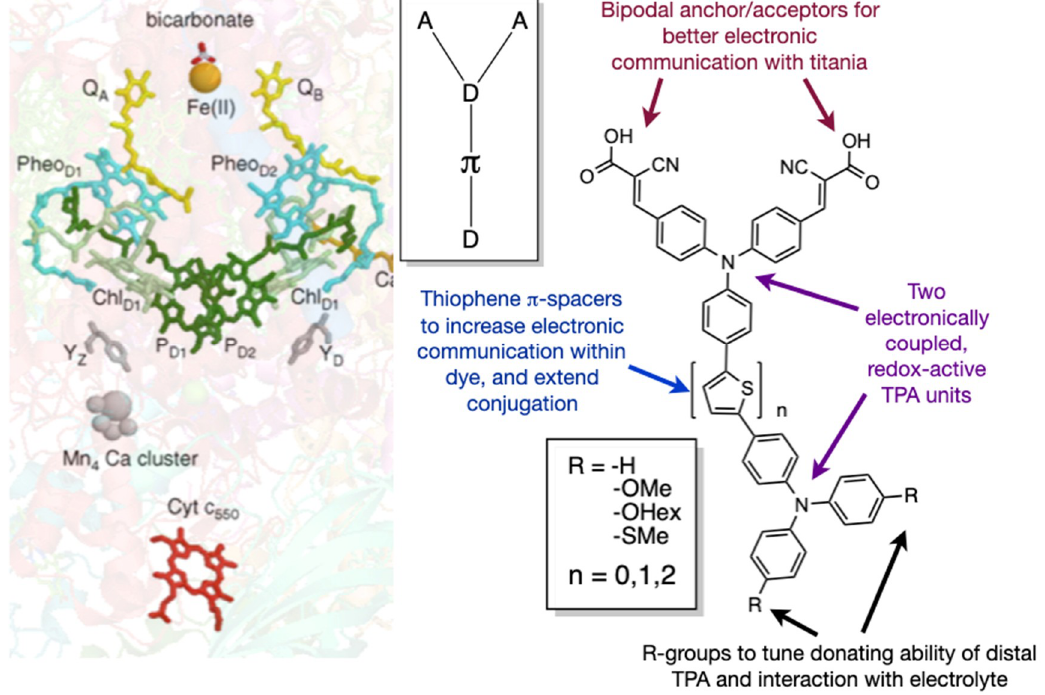
Figure 1. A family of bichromic-bipodal dyes inspired by the molecular machinery found in Photosystem II (PS2-left). Bichromic (two redox coupled donors) and bipodal (two acceptor anchors) (right) mimic the cofacial porphyrin dimer P680 and the two quinone acceptor pathways found,